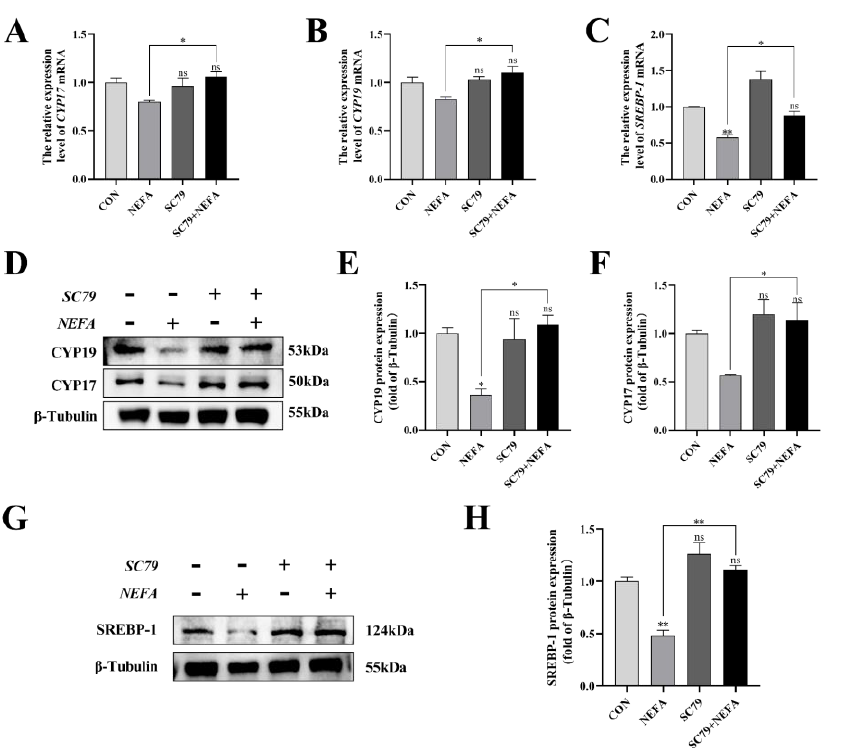
Figure 8. Effects of AKT activator SC79 on NEFA − induced steroid hormone synthesis gene expression in BGCs. Experiments were performed after NEFA treatment of BGCs for 24 h with or without SC79 pretreatment for 2 h. ( A , B , D – F ) CYP17 and CYP19 protein and gene expression in BGCs under treatment with AKT activator SC79. ( C , G , H ) SREBP − 1 protein and gene expression in BGCs. The quantification of the relative protein levels (performed using Image J) is shown under the band (protein/ β − Tubulin). This experiment was repeated 3 times, and data are expressed as mean ± standard errors of the mean (SEM), * p < 0.05; ** p < 0.01; ns, not significant.